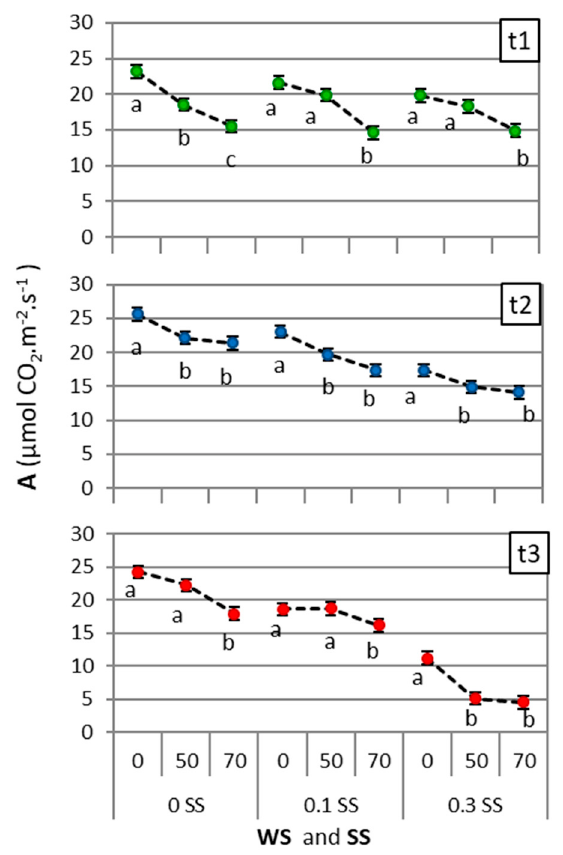
Figure 7. Effect of WS × SS × t interaction on net photosynthetic rate (A) for each time point (t1, t2, and t3, corresponding to 10, 45, and 85 days, respectively). Different letters indicate significant differences ( p < 0.05) between drought levels (WS: 0, 50, or 70, corresponding to 100%, 50%, or 30% water capacity, respectively) for each salinity level (SS: 0, 0.1, or 0.3, corresponding to 0.0, 0.1, or 0.3 M NaCl, respectively). Points are means of 4 tall wheatgrass accessions and 4 blocks ( n = 16). Bars indicate the means standard error.